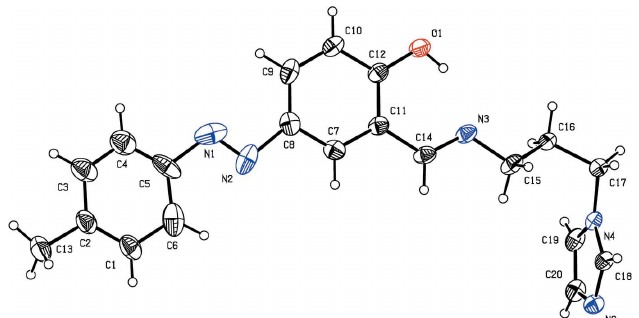
Figure 1 The molecular structure with displacement ellipsoids drawn at the 30% probability